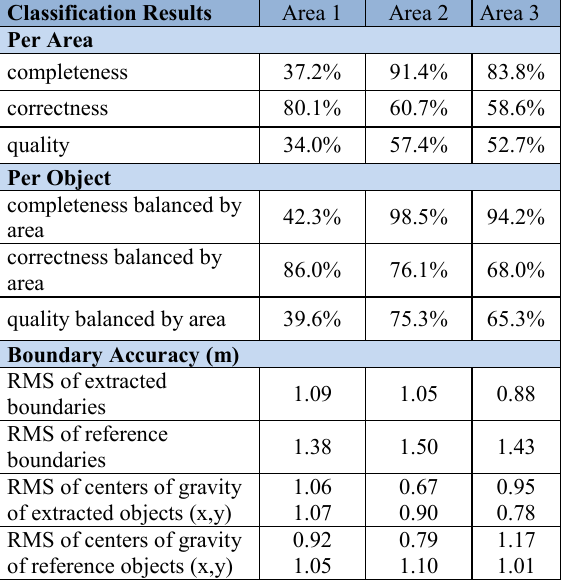
Table 2. Classification results for the trees